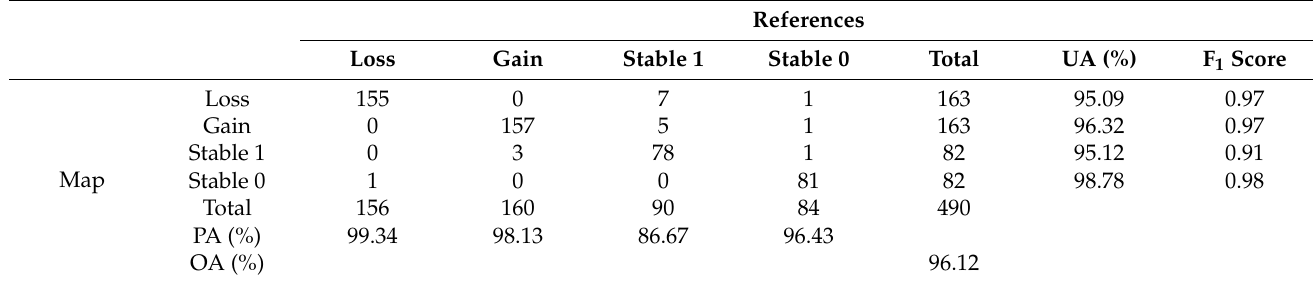
Table 3. Error matrix of sample counts at the mangrove change map.